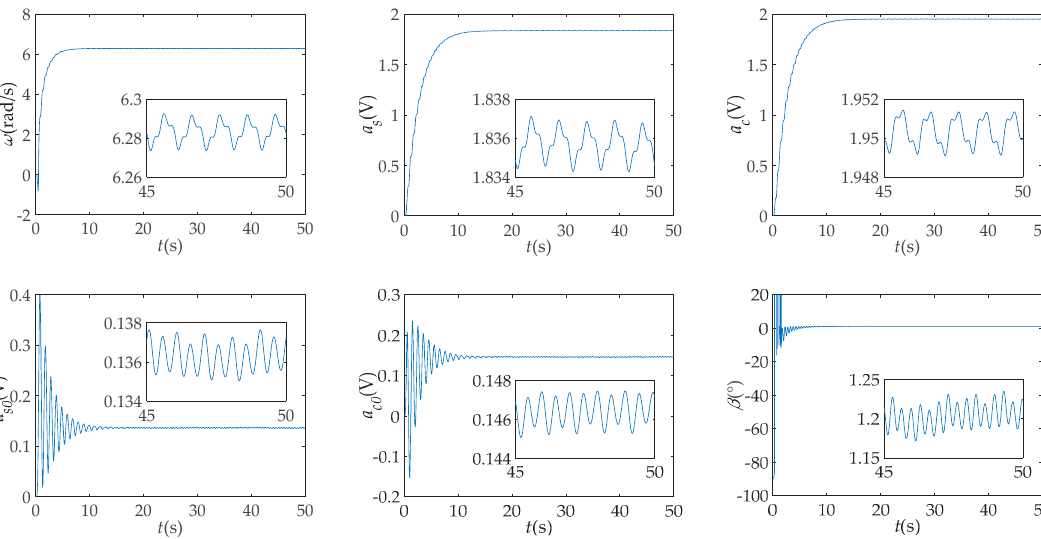
Figure 7. Estimations of angular velocity and imperfect parameters in simulation before filter (Group 1).